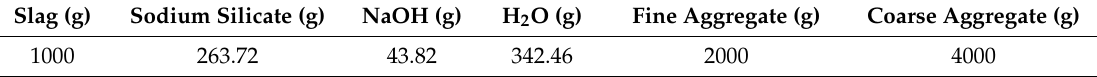
Table 2. Mixture proportions used in this study.